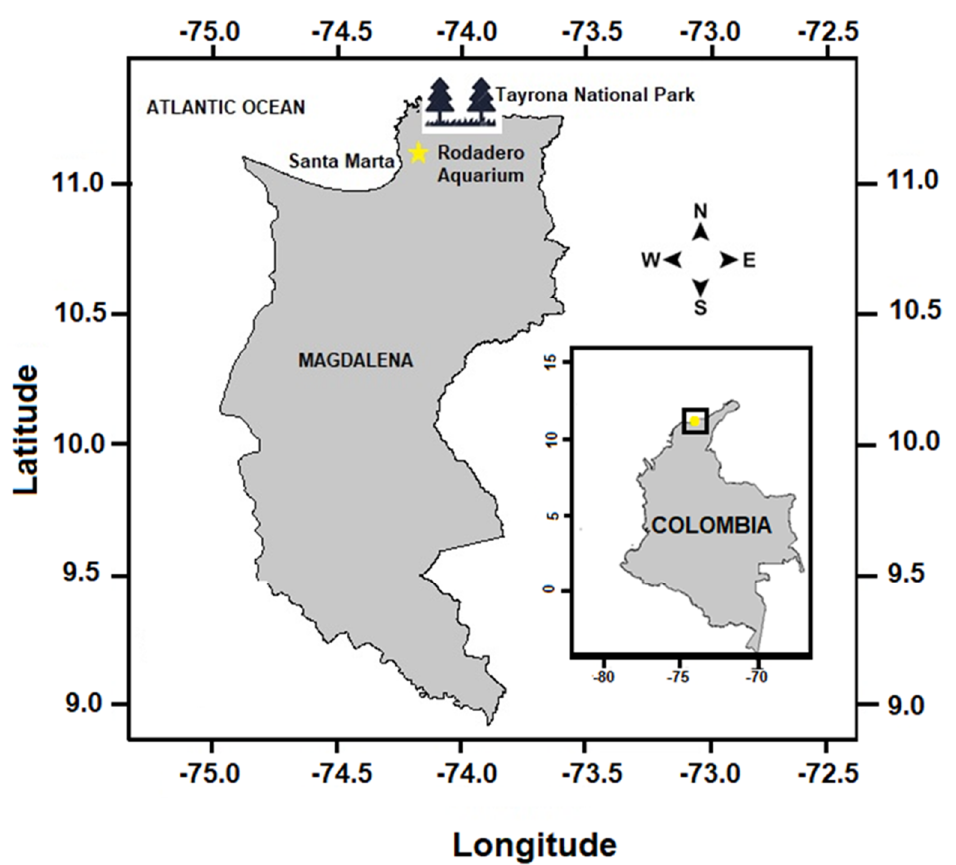
Figure 2. Location of El Rodadero Aquarium (11 ◦ 13 (cid:48) 01 (cid:48)(cid:48) N 74 ◦ 14 (cid:48) 14 (cid:48)(cid:48) W), Santa Marta (Colombia), site for peripheral blood sampling site of the five individuals of loggerhead sea